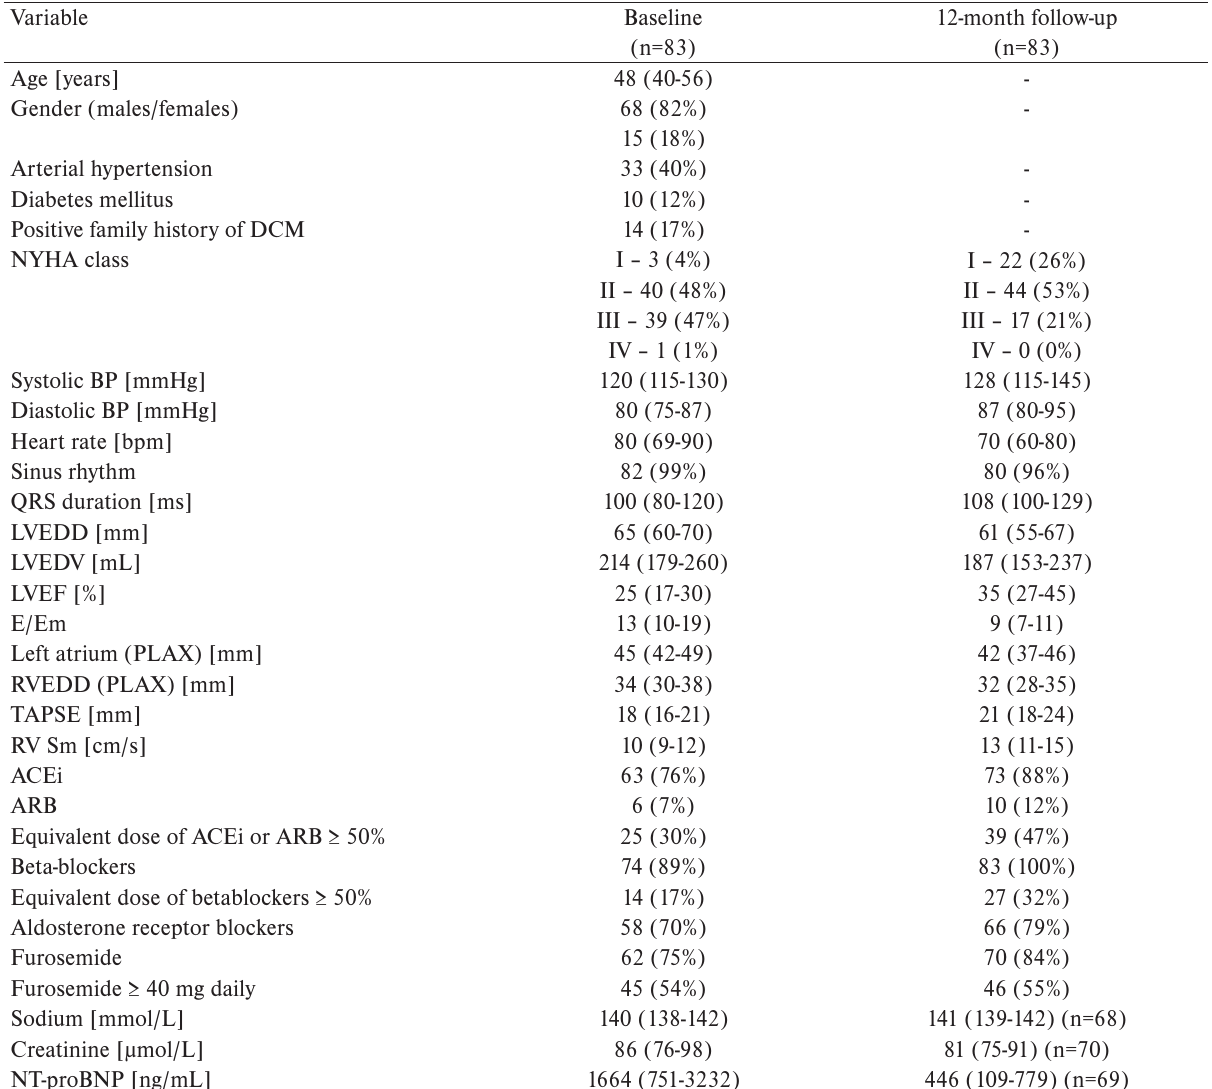
Table 1. Patient